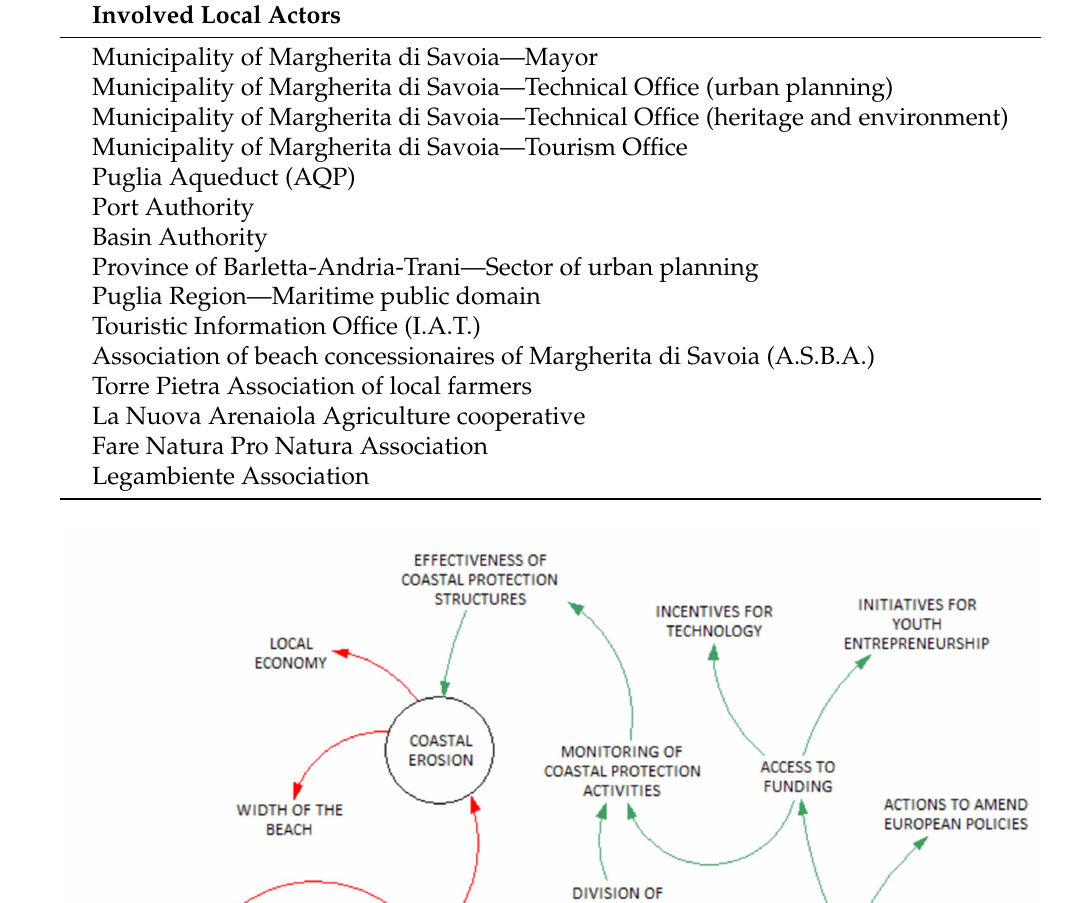
Table 2. List of Scenario Workshop participants.